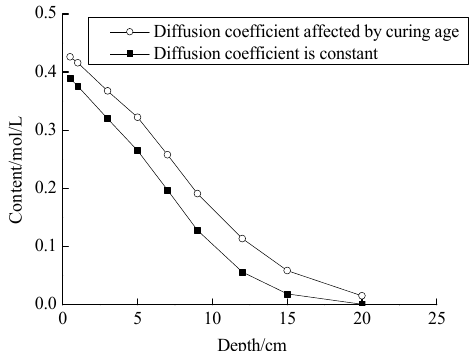
Figure 10. The relationship between chloride concentration and depth.